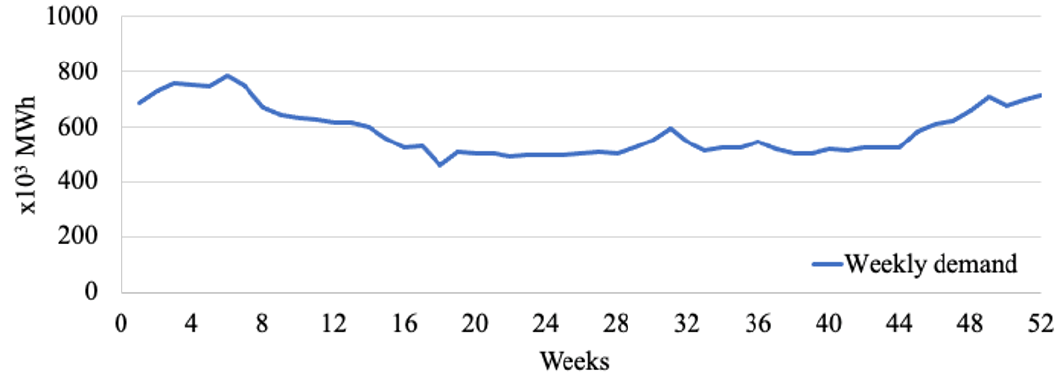
Figure 7. The real electricity consumption data of Hokkaido in 2019.